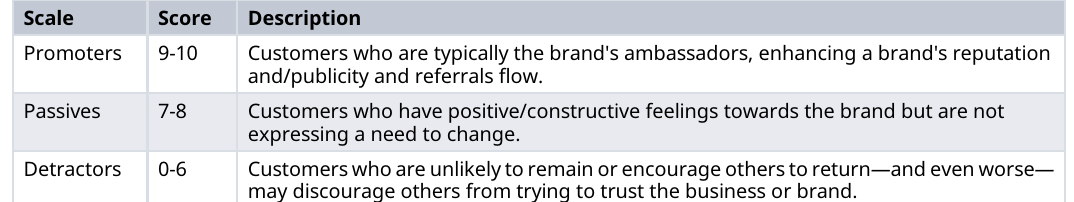
Table 1. Net Promoter (NPS) scale. Scale